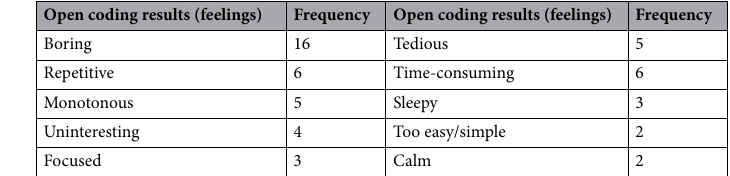
Table 1. Open coding feelings and frequency for each feeling after Experiment